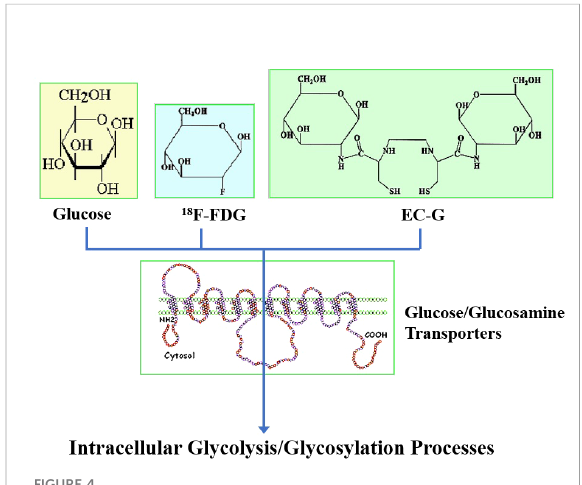
FIGURE 4 Structures of fl uorodeoxyglucose (FDG), glucosamine and ethylenedicysteine-glucosamine